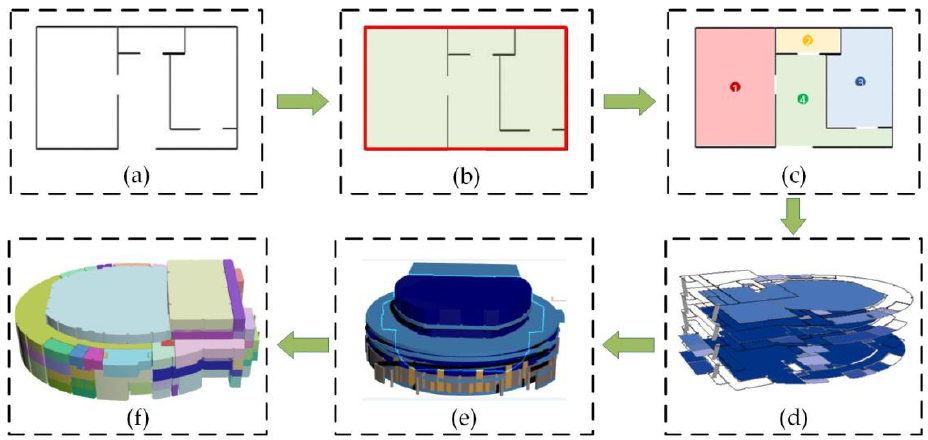
Figure 2. Overview of the proposed indoor space extraction procedure: ( a ) Building components; ( b ) calculation of the indoor space boundary of a single floor; ( c ) indoor single-floor space extraction of a building; ( d ) identification of the downward connectivity of single-floor space; ( e ) indoor cross-floor space extracting of a building; and ( f ) extraction result, ( a – c ) are part of the building in ( d ) for clear